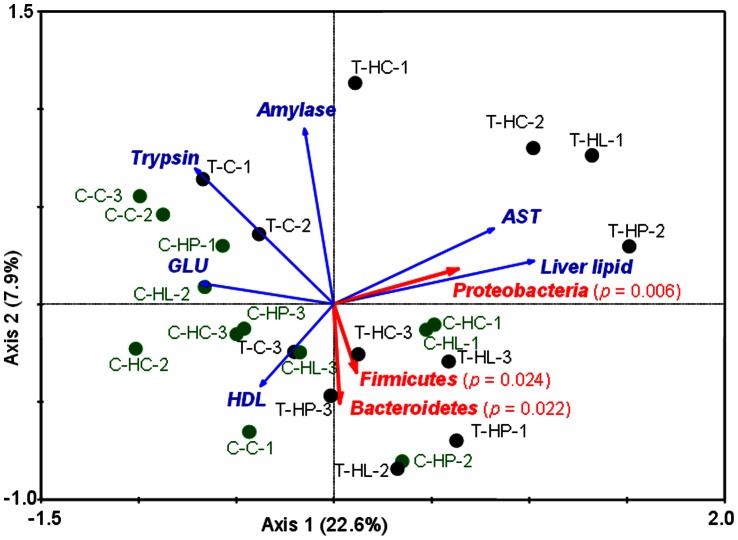
Triplot of the redundancy analysis (RDA) showing significant relationship between metabolic-related factors (response variables) and microbial groups (explanatory variables).First and second ordination axes were plotted, representing 22.6% and 7.9% of the variability in the data set, respectively. P-values obtained by Monte Carlo test were reported. For each sample code, the first letter T represents transgenic fish, and C wild-type controls; the middle letter(s) indicates the diet treatments (C: control diet, HP: high protein diet, HC: high carbohydrate diet, HL: high lipid diet), and the last numbers represent replicated samples. GLU represents glucose, AST aspartate aminotransferase, and HDL high-density lipoprotein.